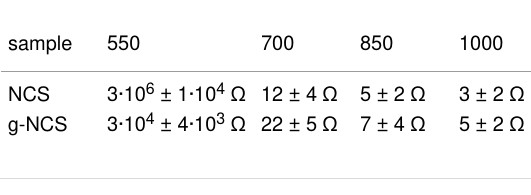
Table 5: Resistance of the catalyst films of NCS and g-NCS (without catalyst film: 2 Ω ).